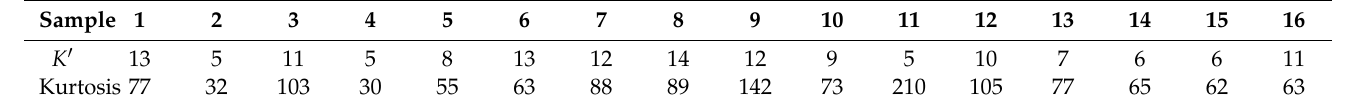
Figure 6. K and local maximum envelope kurtosis. Table 6. Relationship between 4-channel K’ and global maximum envelope